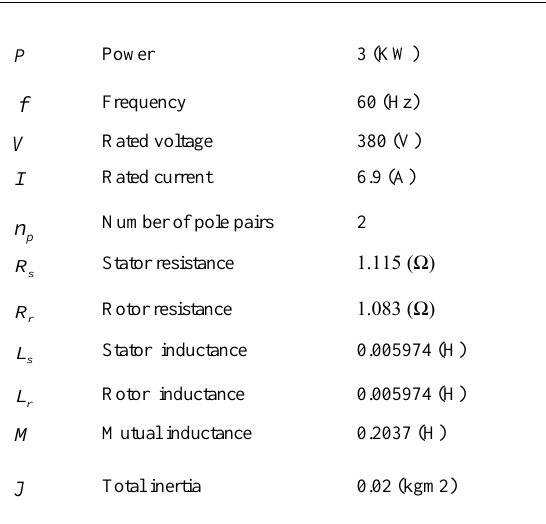
Table 1. Rated parameters of case study induction